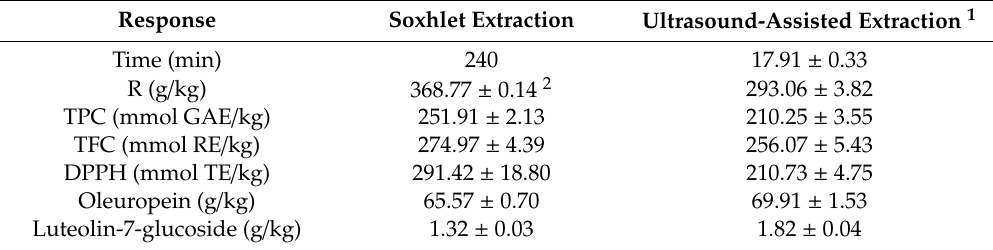
Table 4. Comparison of both extraction methods applied in this work.